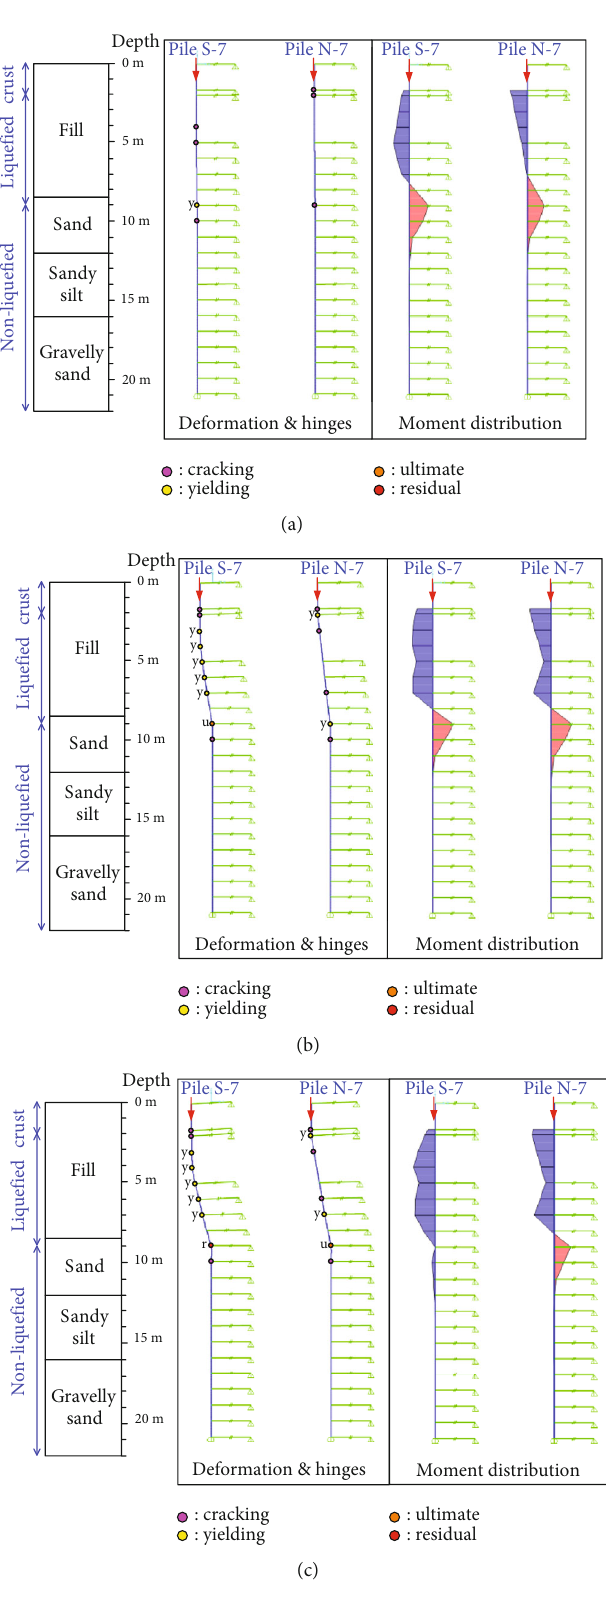
Figure 8: Deformation, plastic hinges, and moment distribution along the piles (lateral spreading as fl ow displacement, with axial load). (a) Yielding state. (b) Ultimate state. (c) Final